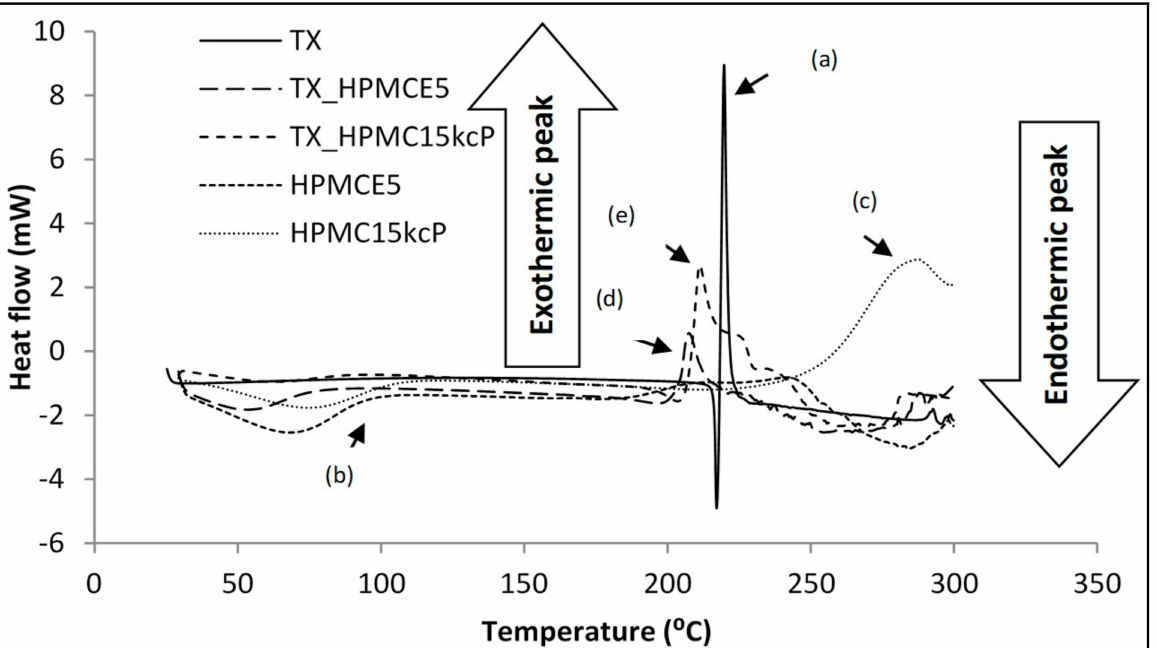
Figure 3. The differential scanning calorimetry thermogram of TX ( a ), HPMC E5 ( b ), HPMC 15kcP ( c ), and physical mixtures TX-HPMC E5 ( d ) and TX-HPMC 15kcP ( e ).